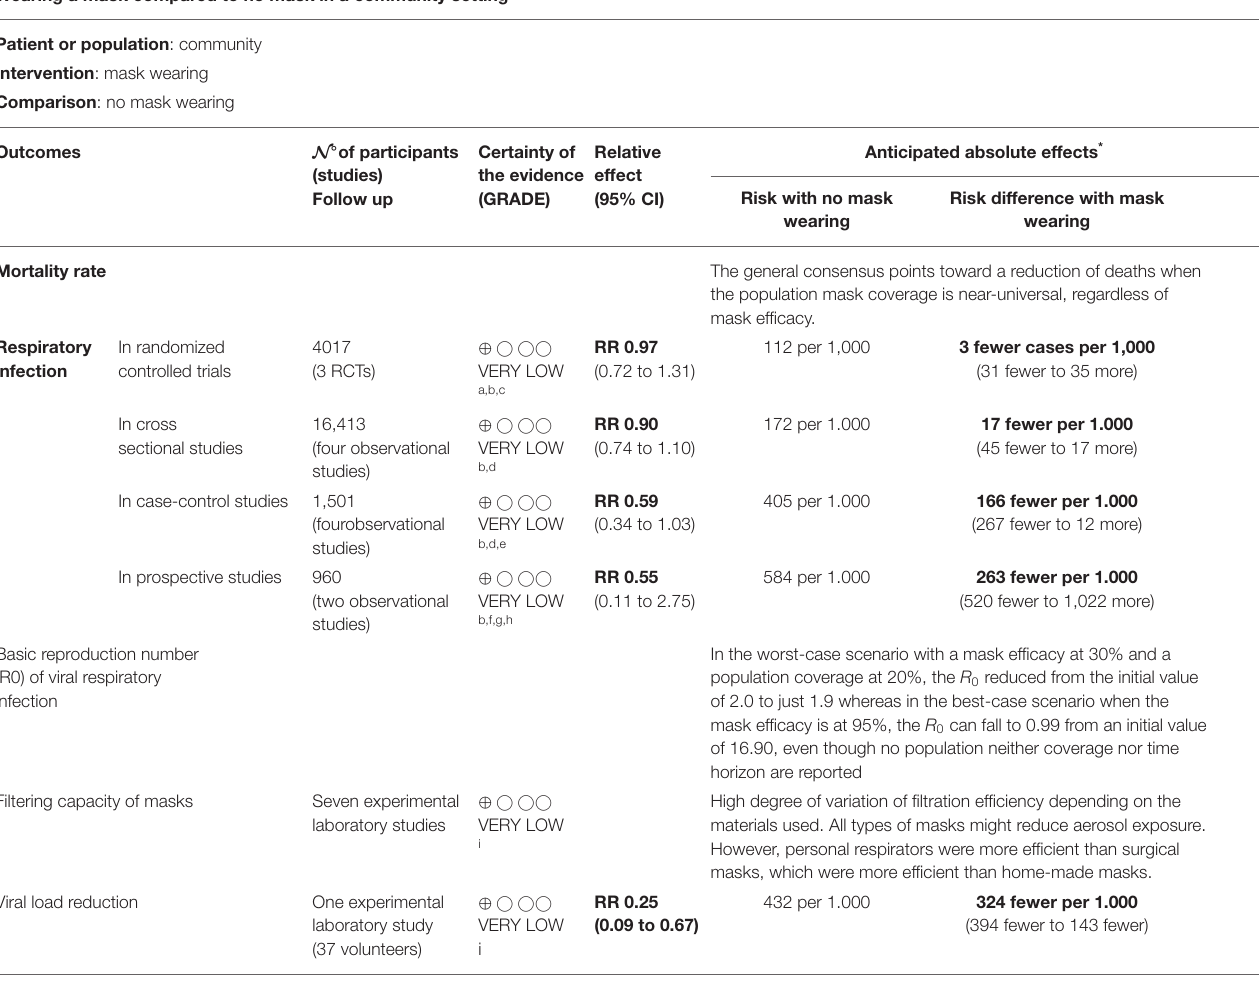
TABLE 3 | Summary of findings. Wearing a mask compared to no mask in a community setting Patient or population :